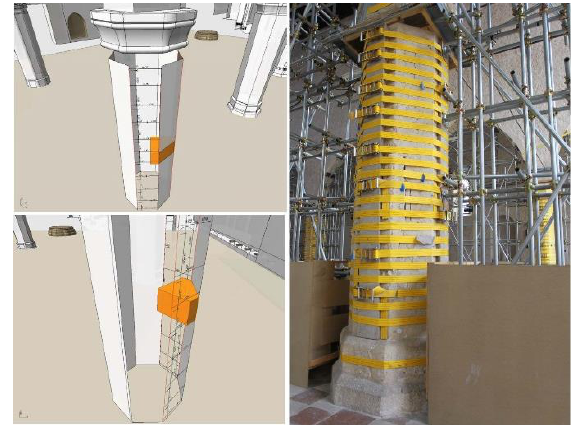
Figure 9. NURBS solid of the North wall of the Basilica created in Rhino and imported through cad schemes in ©Midas for structural simulation.